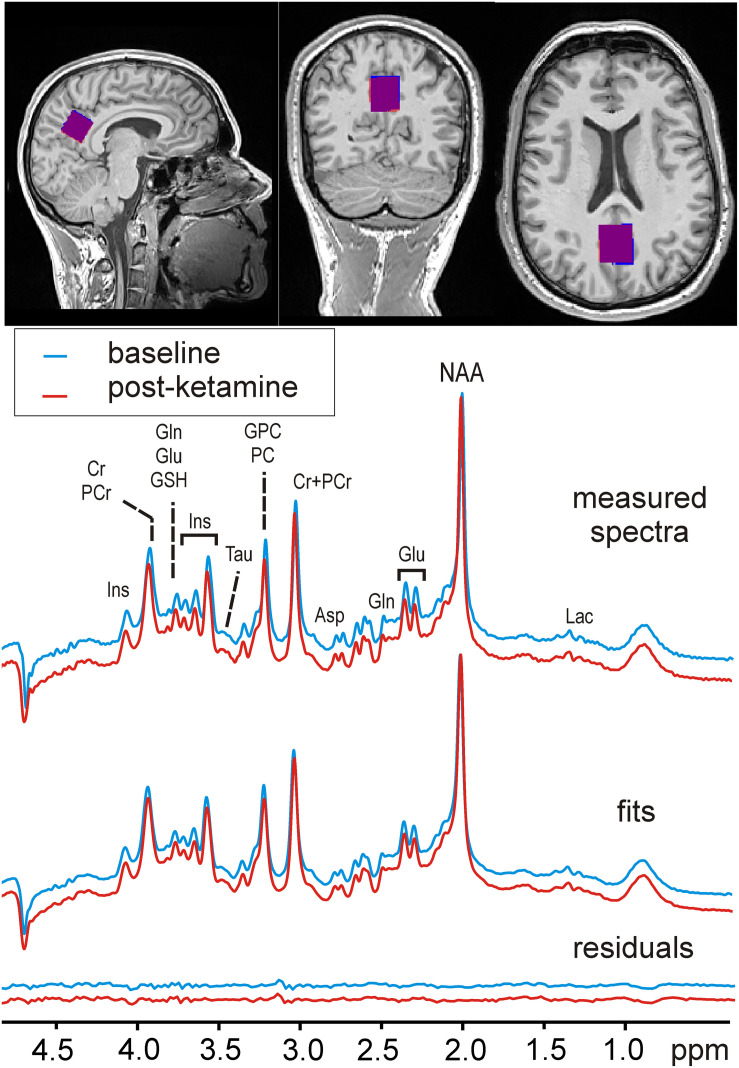
Voxel position and sample MR spectra. An example of spectra acquired before (MRI1) and after ketamine administration (MRI2) is shown along with their fits and residuals of the fits resulting from LCModel quantification. The insets with T1-weighted MPRAGE images depict the typical MRS-voxel position in the posterior cingulate cortex in MRI1 (red) and MRI2 (blue), and their mutual overlap (in purple).